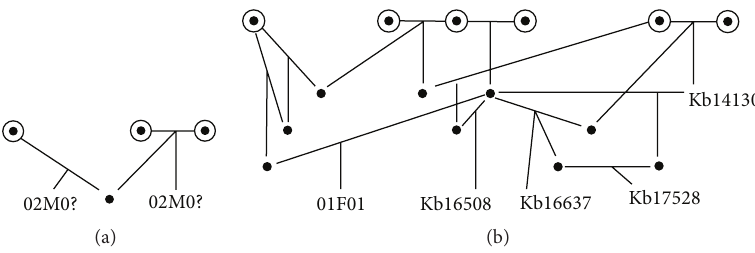
Figure 2: Part of the pedigree of the captive Sus cebifrons populations in Europe (a) and the US (b) reconstructed from the studbook files. Dots represent individuals, circles indicate founders (individuals with parents indicated as “WILD” in the studbook file), and sampled individuals are represented by their number as described in Table 1. For the two individuals from Rotterdam zoo, it is not known which sample is from which individual, and therefore they are indicated with a question mark.